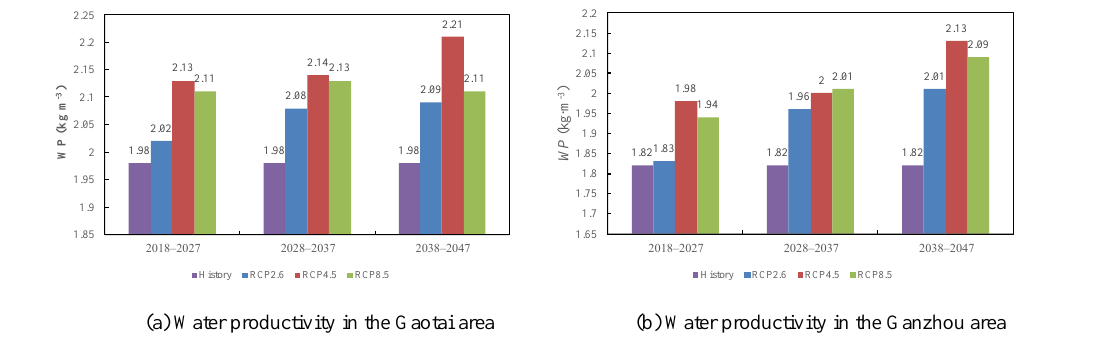
Figure 7. Decadal changes of corn water productivity in the middle agricultural region of the HRB under RCP scenarios.